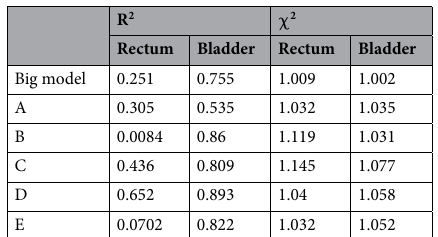
Table 4. R 2 and χ 2 values for regression model in each model. R 2 Coefficient of determination; χ 2 Chi squared.